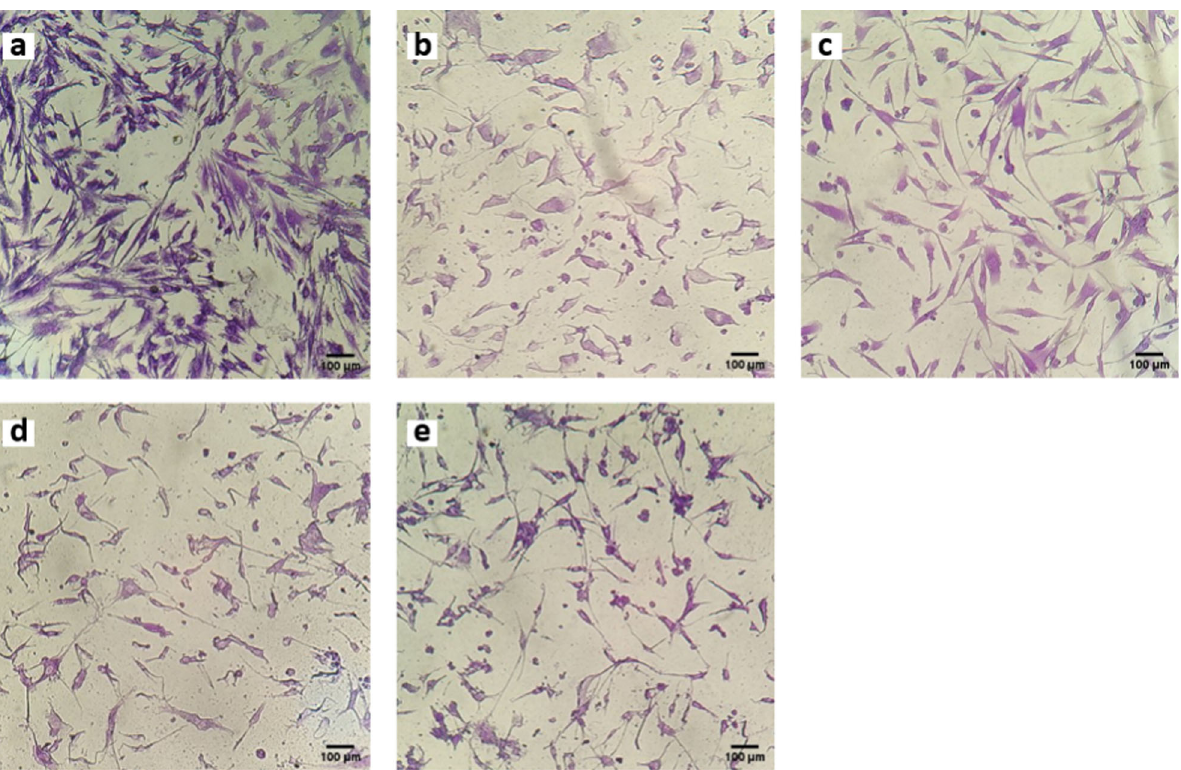
Fig. 9 Microscopic images of Crystal Violet-stained fi broblasts in contact with extracts of the fi lms for 24 h. a CWE, ( b ) PU, ( c ) PU-PEG 0.05, ( d ) PU-PEG 0.10, ( e ) PU-PEG